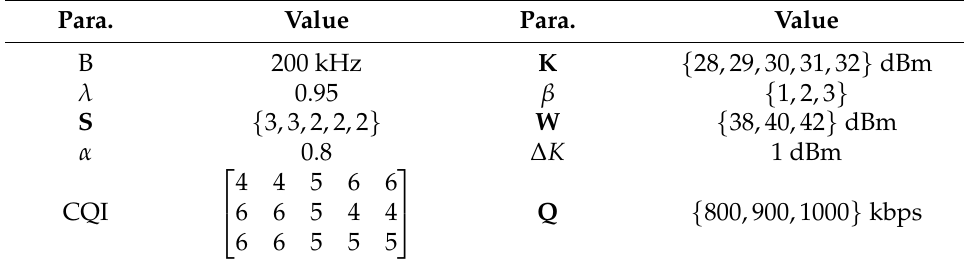
Table 1. Configuration